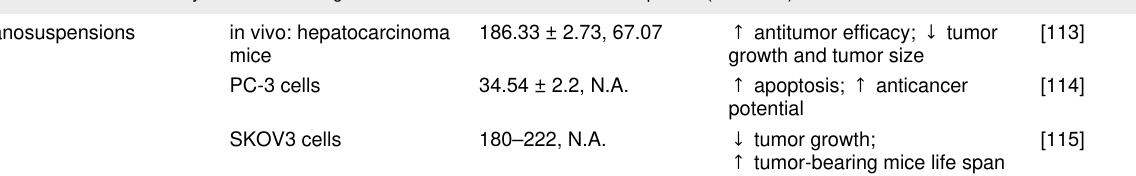
Table 1: CUR-loaded nanosystems in which significant anticancer effects have been reported. (continued) nanosuspensions in vivo: hepatocarcinoma mice